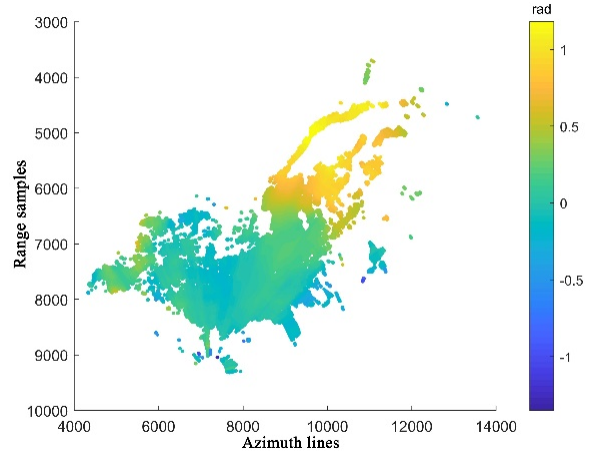
Fig 17 . Residual phase map after filtering. The residual phase is filtered by the spatial domain filtering algorithm, and the filtered phase is obtained. Figure 18. Residual phase diagram after unwrapping. The interference phase contains only a small amount of deformation phase and atmospheric phase, so it is easier to untangle and reduce the unwinding error.